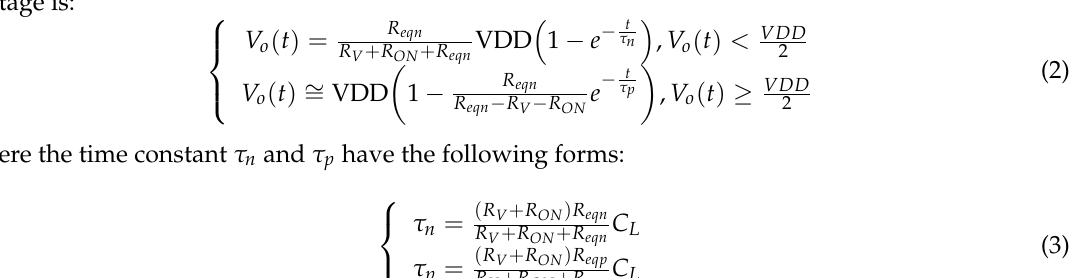
Figure 3. Delay cell ( a ) Block diagram ( b ) Equivalent schematic when signals R and EN_TDC are connected to the voltage supply VDD.